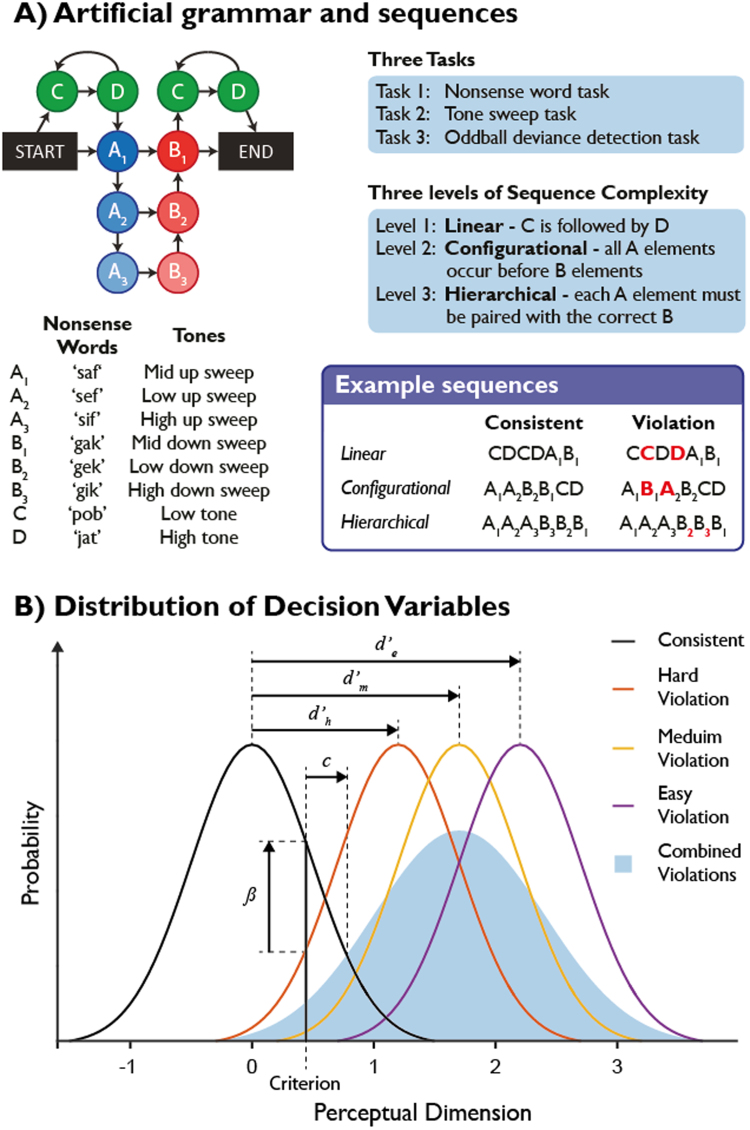
A: Artificial grammar structure and stimuli. B: Cartoon illustrating the distribution of parametric decision variables for an hypothetical experiment with easy, medium and hard to detect rule violations. d′ represents the single subject discriminability of each rule violation, while c and β represent different measures of bias (i.e. in our case the tendency to say that a sequence is grammatical if there is no evidence to the contrary). Each rule violation has its own d′ measure, reflecting its respective discrimination difficulty, while the bias measures apply to the experimental context as a whole.